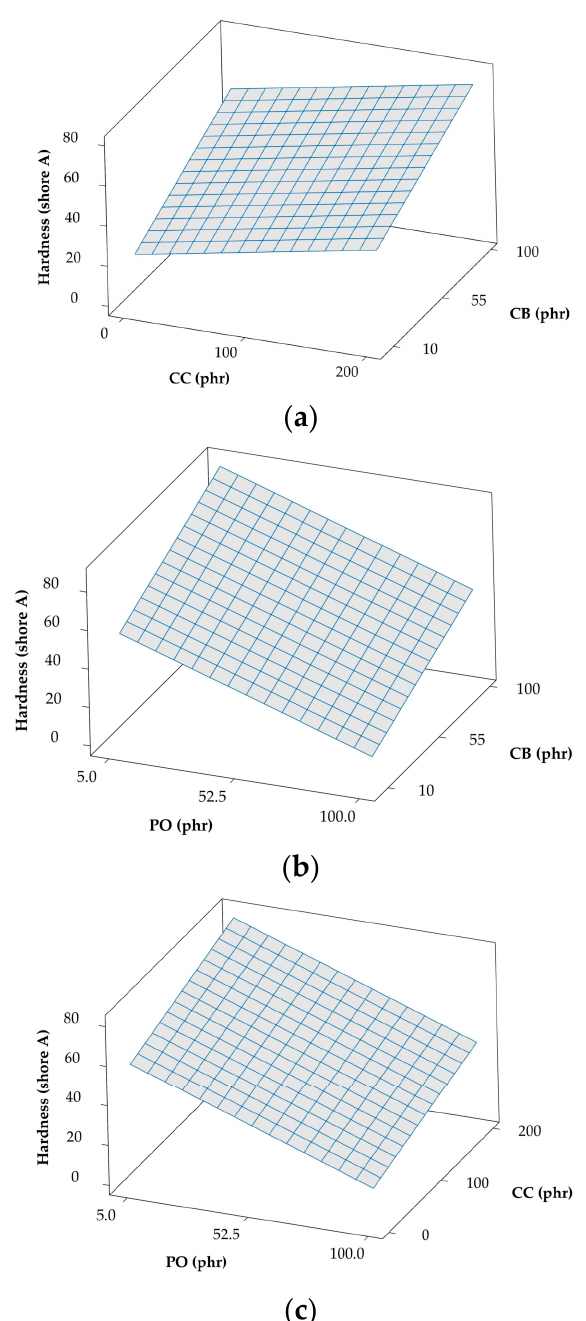
Figure 2. Response cross-correlation surface plots of hardness (Shore A) with various combinations of additives: ( a ) china clay (CC) and carbon black (CB) (paraffinic oil (PO) held constant at 52.5), ( b ) PO and CB (CC held constant at 100), and ( c ) PO and CC (CB held constant at 55).